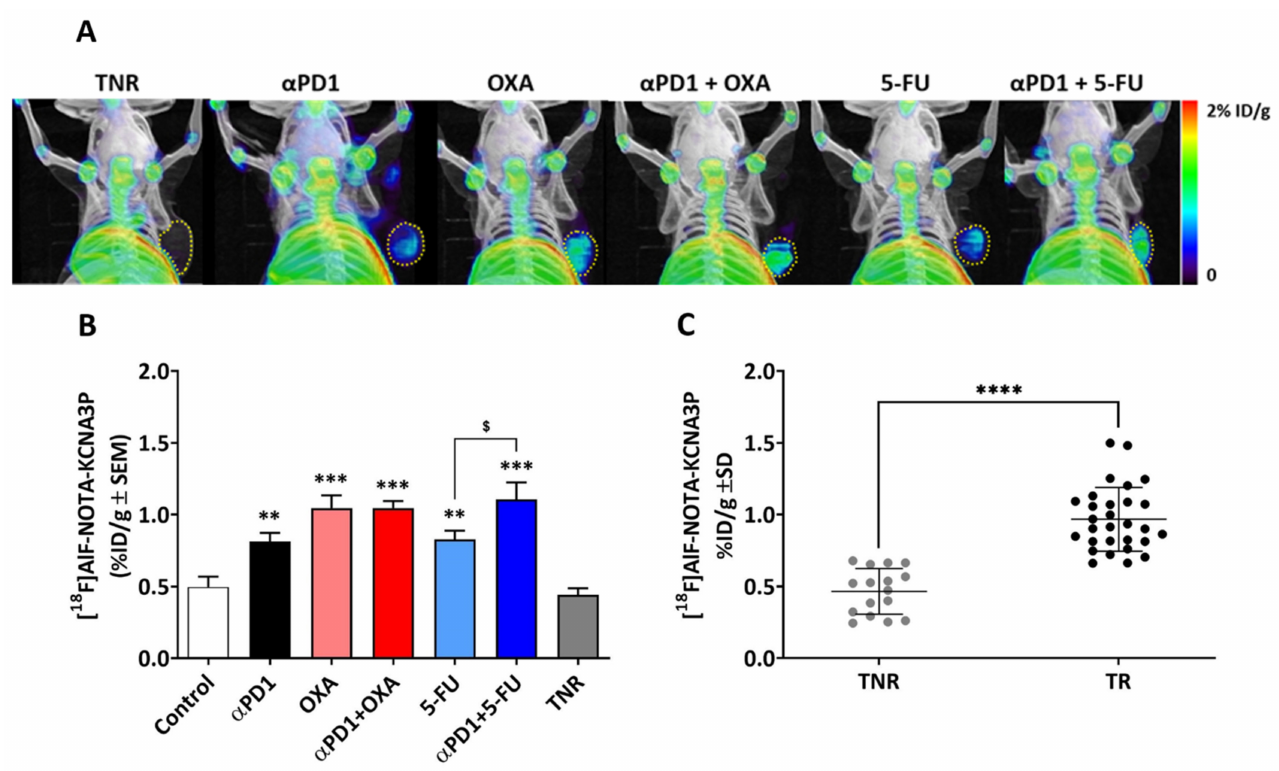
Figure 2. ( A ) Selected MIP images demonstrating [ 18 F]AlF-NOTA-KCNA3P uptake into tumours responding to α PD1, oxaliplatin (OXA), combined α PD1 + OXA, 5-fluorouracil (5-FU), combined α PD1 + 5-FU or non-responding tumours (TNRs). Tumour borders are delineated by yellow dotted lines. ( B ) Graphical representation of [ 18 F]AlF-NOTA-KCNA3P tumour uptake values in each treatment arm ( n = 6–10 mice/group; ** p < 0.01, *** p < 0.001 compared to TNRs; $ p < 0.05 compared to 5-FU; data shown as the means %ID/g ± S.E.M.). ( C ) Individual [ 18 F]AlF-NOTA-KCNA3P tumour